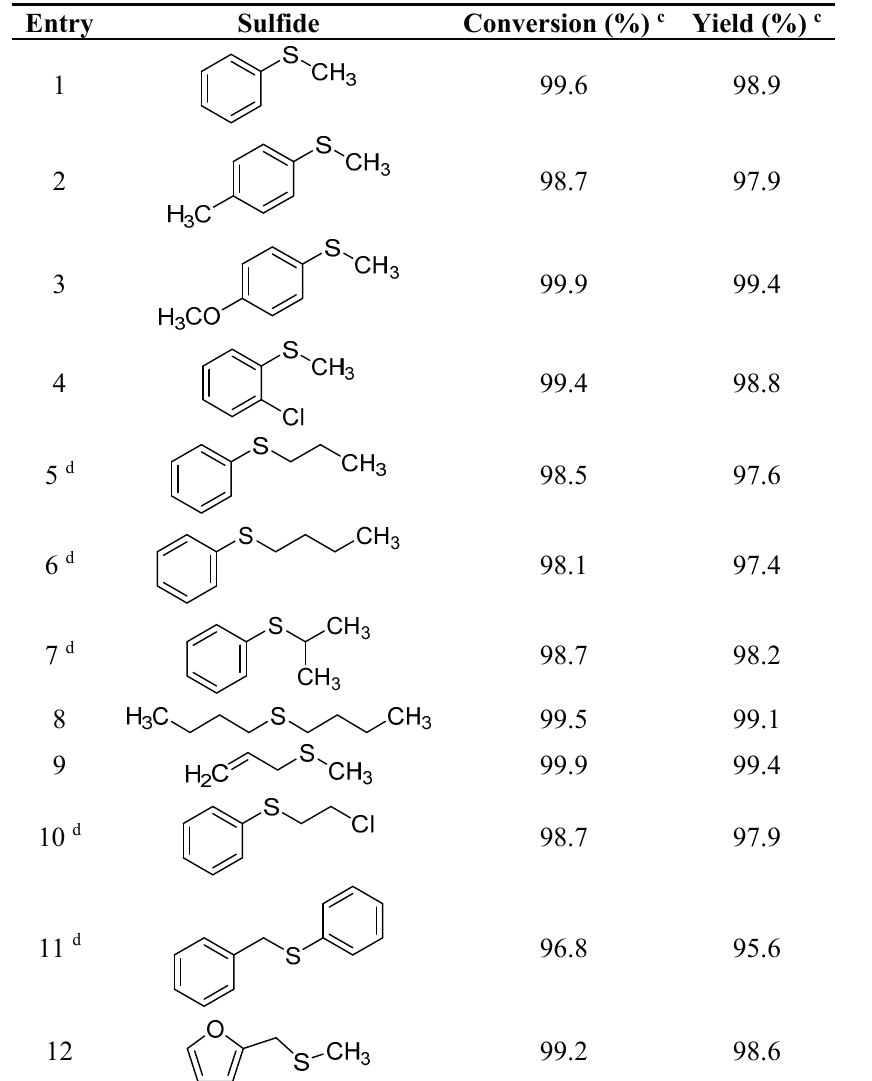
Table 5. Oxidation of various sulfides to sulfoxides with 30% H 2 O 2 catalyzed by camphor-10-sulfonic acid in pH 1.30 a,b